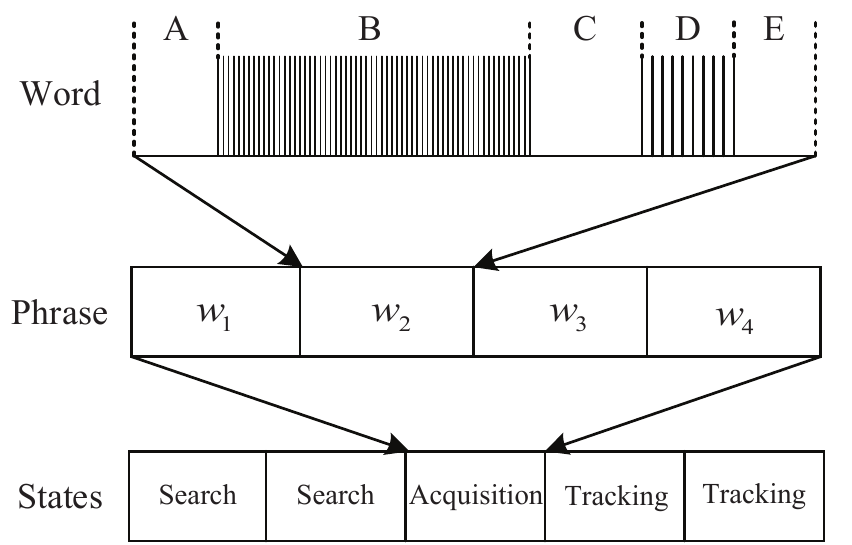
Figure 1. A common layered MFR signal